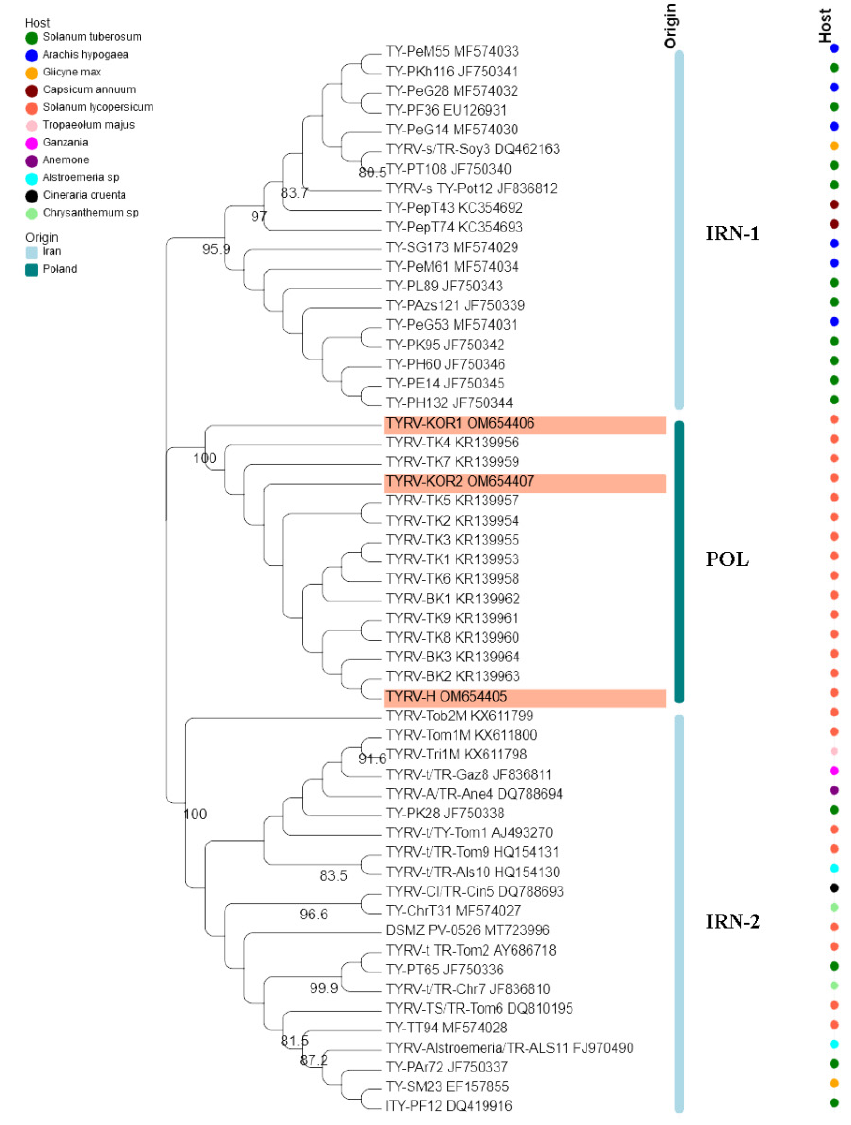
Figure 3. Phylogenetic tree constructed based on nucleocapsid (N) protein gene nucleotide sequences of 55 tomato yellow ring virus (TBRV) isolates. Double names of some isolates correspond to names of isolates in GenBank and those used by Golnaraghi et al. in their work [30]. Host species and country of origin were represented by dots and lines, respectively. Newly described Polish TYRV isolates are highlighted.